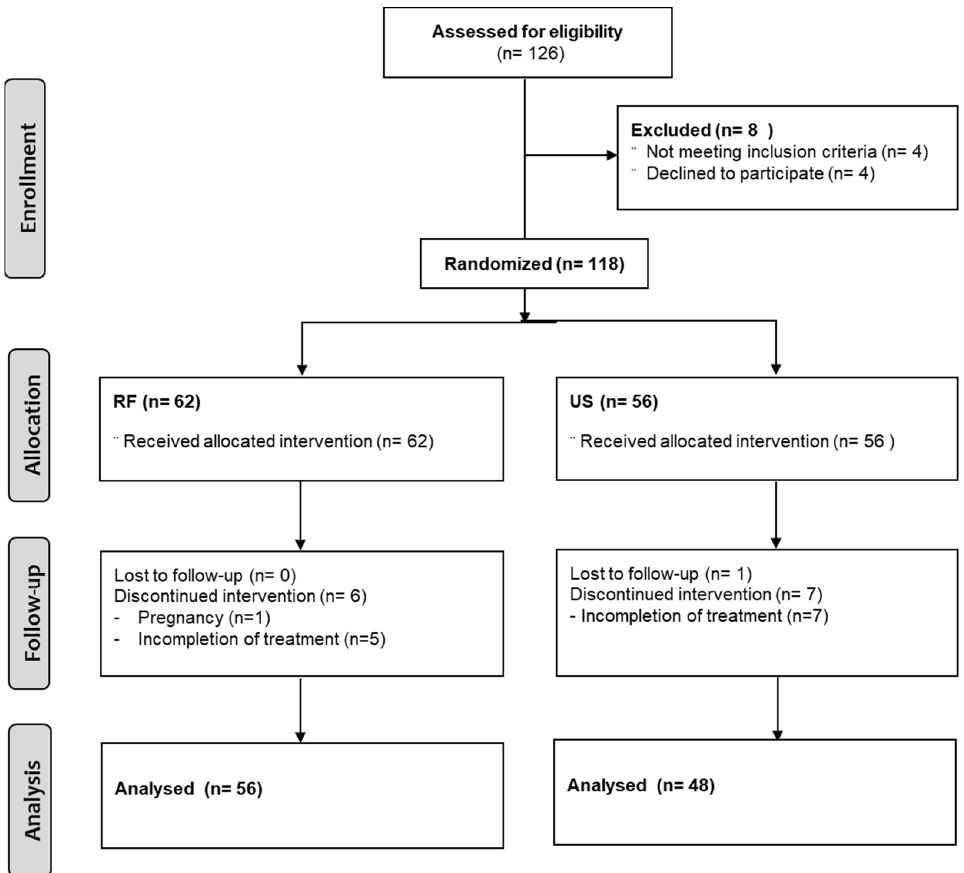
Figure 1. The flow diagram of the study. A total of 118 patients were randomly allocated into the radiofrequency (RF) or the ultrasound (US) group, with 62 patients in the RF group and 56 patients in the US group. Table 1. Demographic characteristics of the patients.